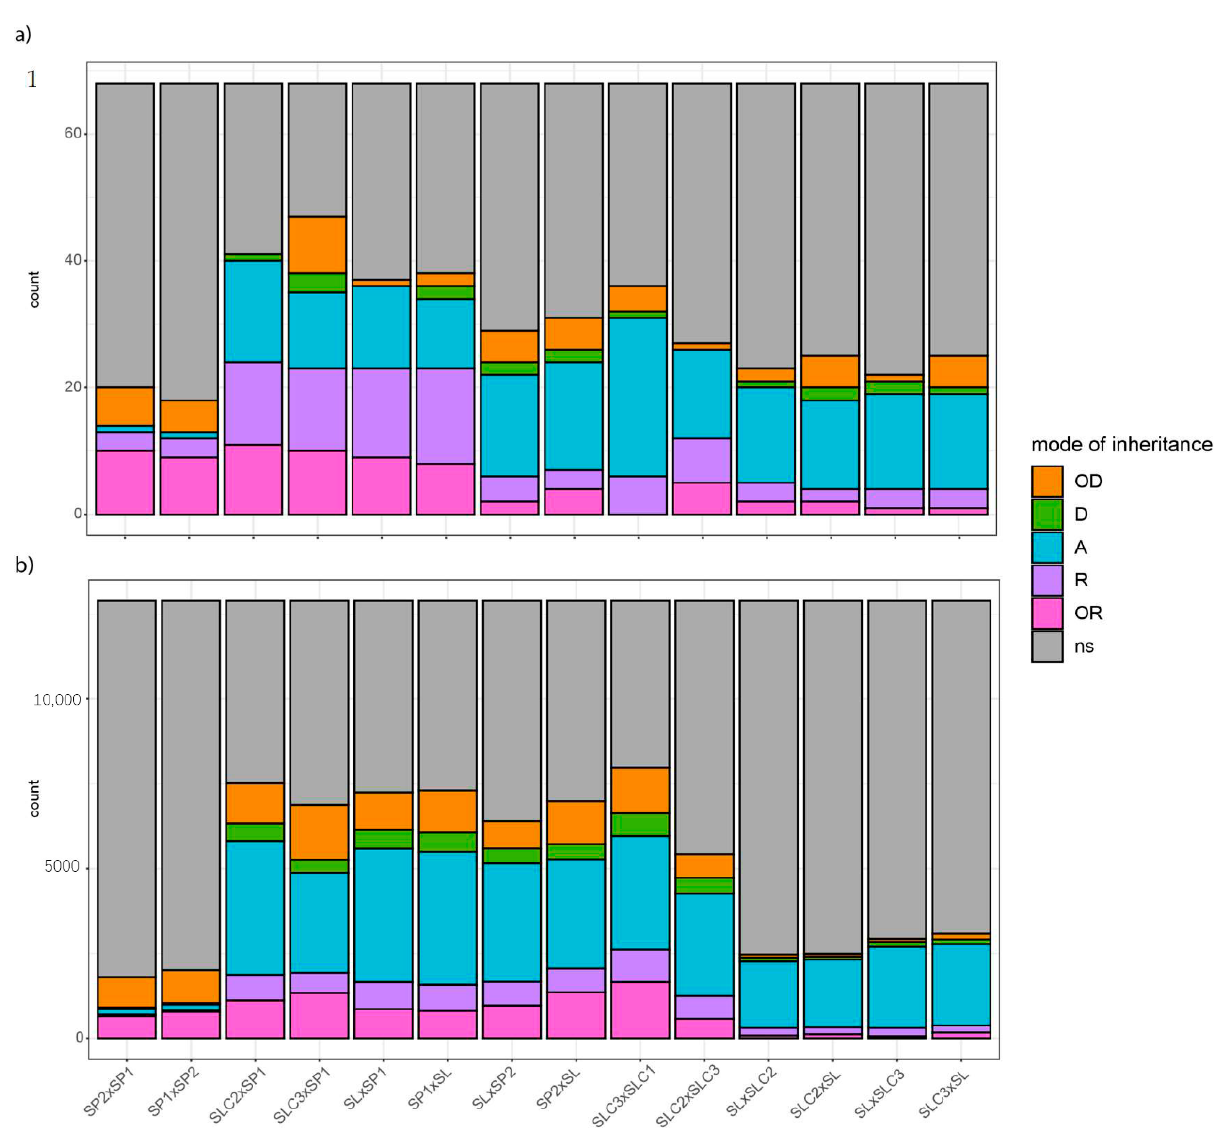
Figure 2. Overall modes of inheritance per cross for: ( a ) 66 metabolites, SSC and weight and ( b ) 12,896 differentially expressed genes (DEGs). The height and color of the barplot indicate the number of traits or DEGs with a specific mode of inheritance. Modes of inheritance are classified as over-recessive (‘OR’), recessive (‘R’), additive (‘A’), dominant (‘D’) or over-dominant (‘OD’) in a given cross. Traits or DEGs that show no significant difference (‘ns’) between at least two individuals of the cross (the two parental lines and HF1) are filled in grey.